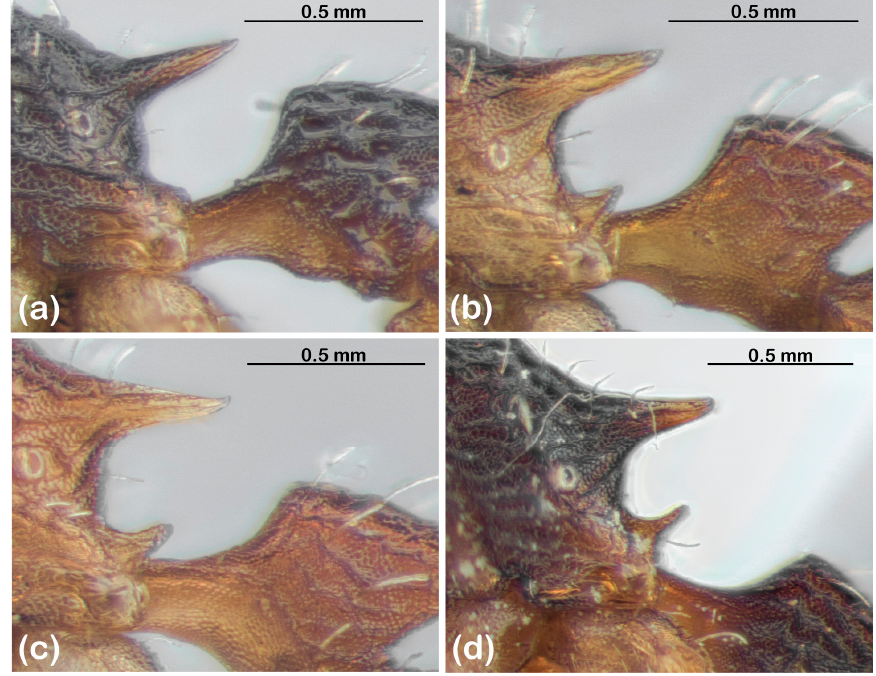
2 Figure 2. Variation in metapleural lobes among species of the T . spininode group. ( a ) T. spininode ;